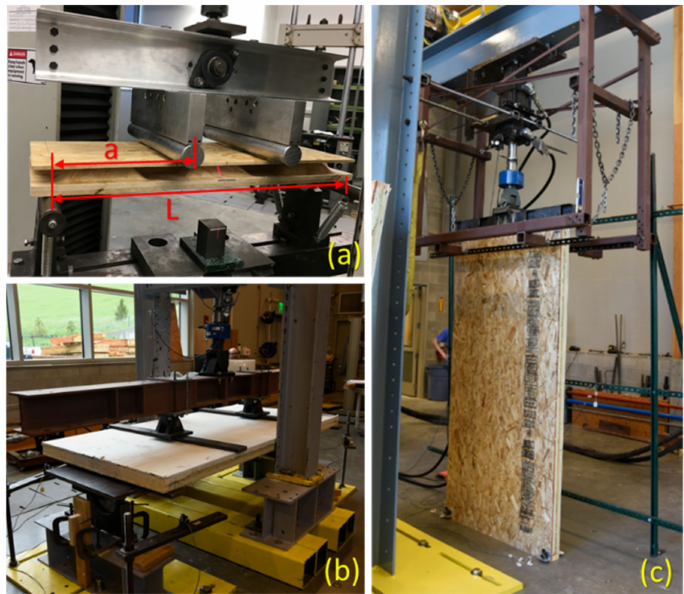
Figure 5. Experimental testing; ( a ) small scale bending of 559 mm long and 1-UC wide specimen from a one-layered core, large scale ( b ) bending, and ( c ) compression testing of a commercial-size two-layered core sandwich panel.